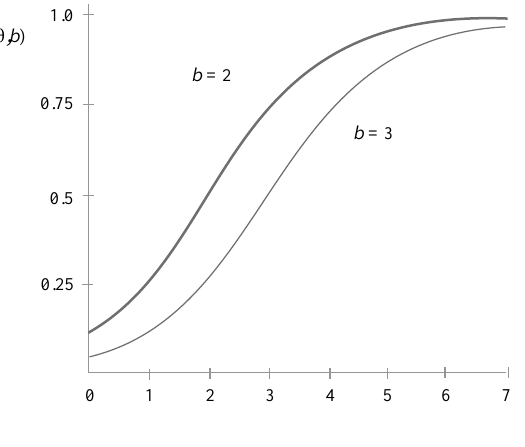
Fig. 1. Graph of function P (θ, b ) for b =2;